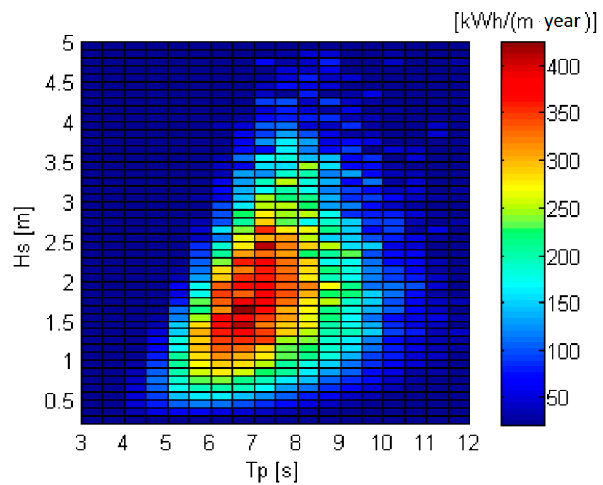
Figure 5. Scattering table of extractable energy along Pantelleria’s coasts [22].